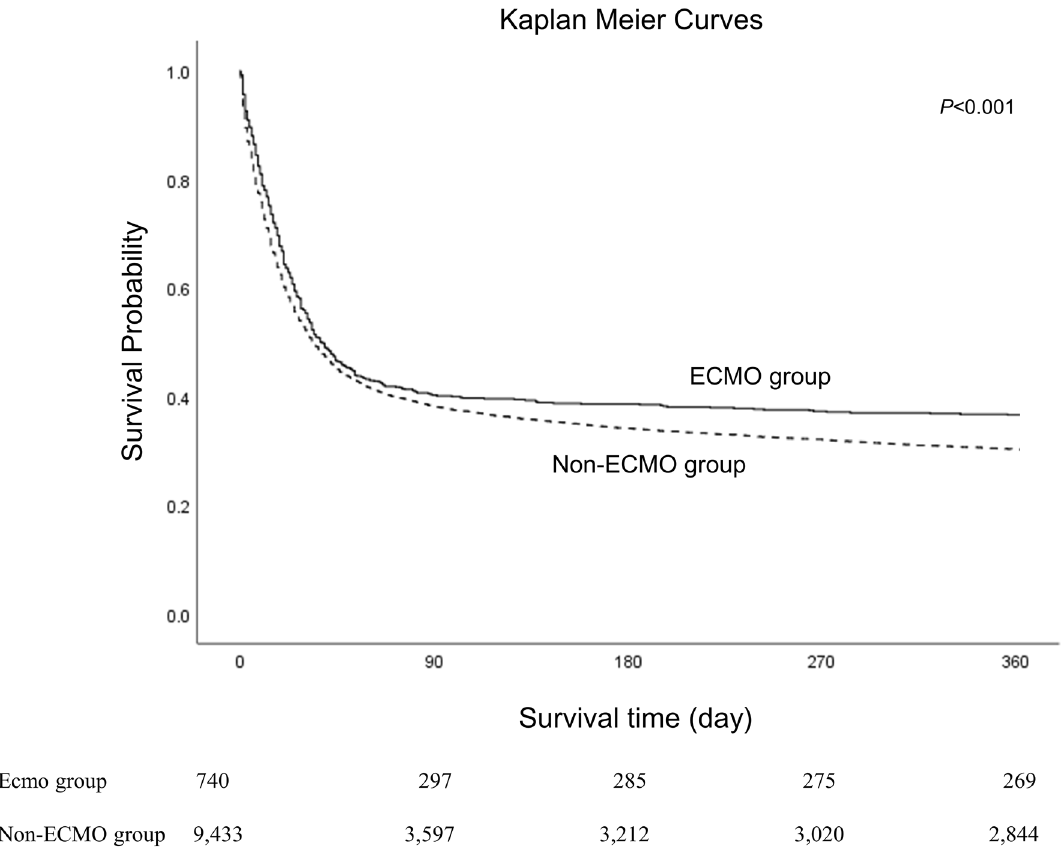
Figure 2. Kaplan–Meier curves of overall survival up to 365 days after ARDS diagnosis in ECMO and non- ECMO groups. ARDS. Acute respiratory distress syndrome, ECMO, extracorporeal membrane